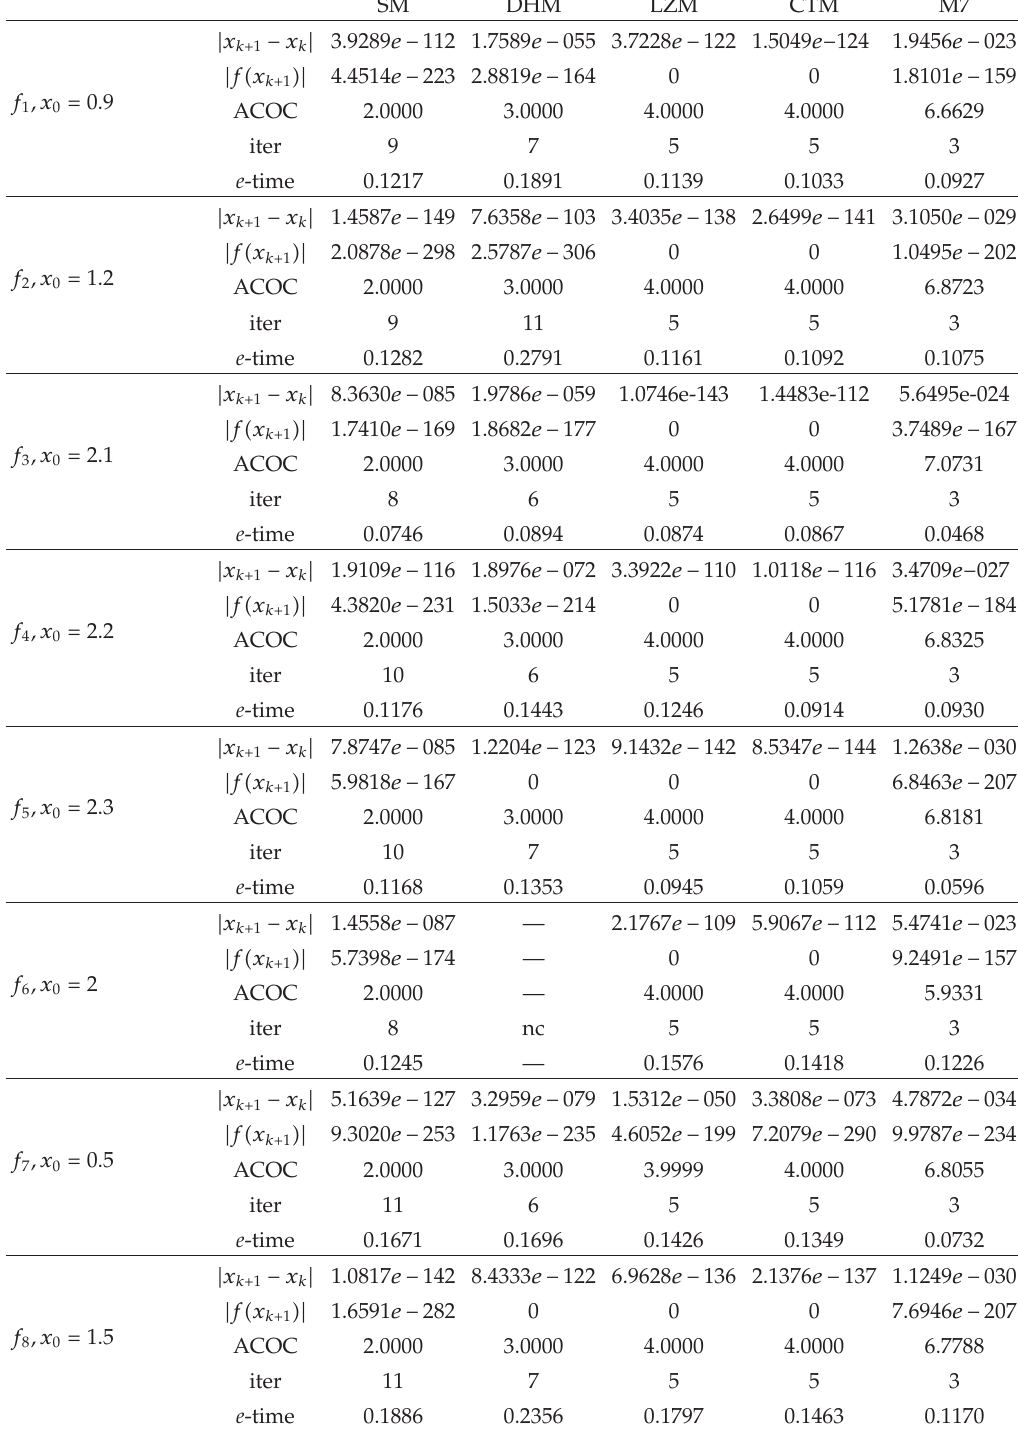
Table 1: Numerical results from f SM DHM LZM CTM